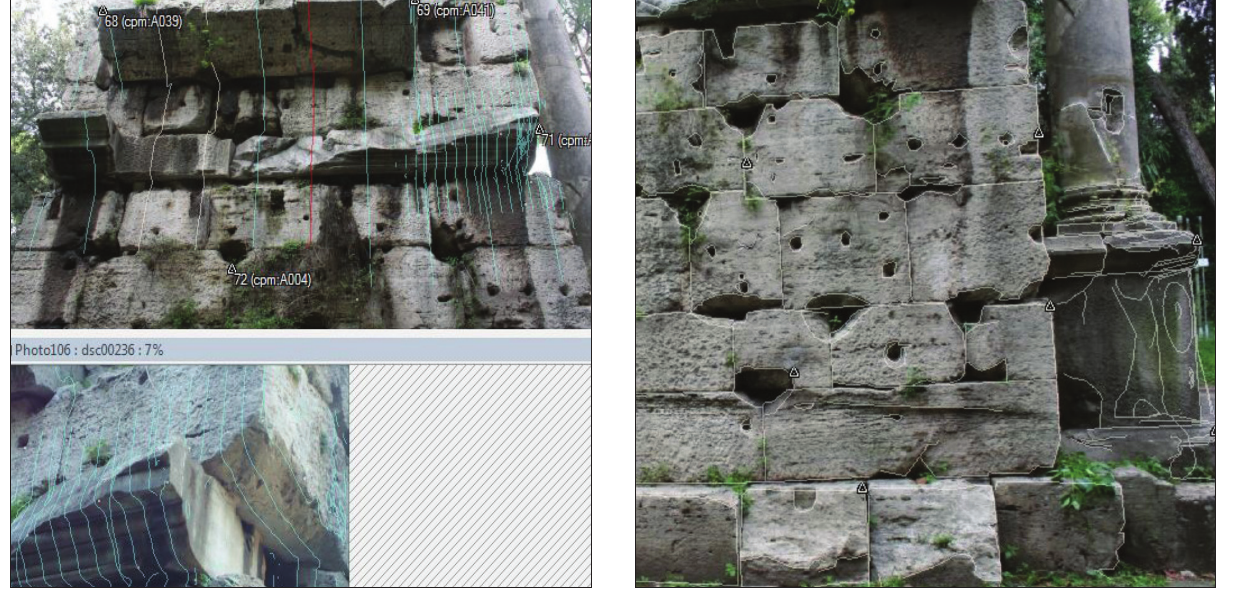
Figure 6. Restitution of West